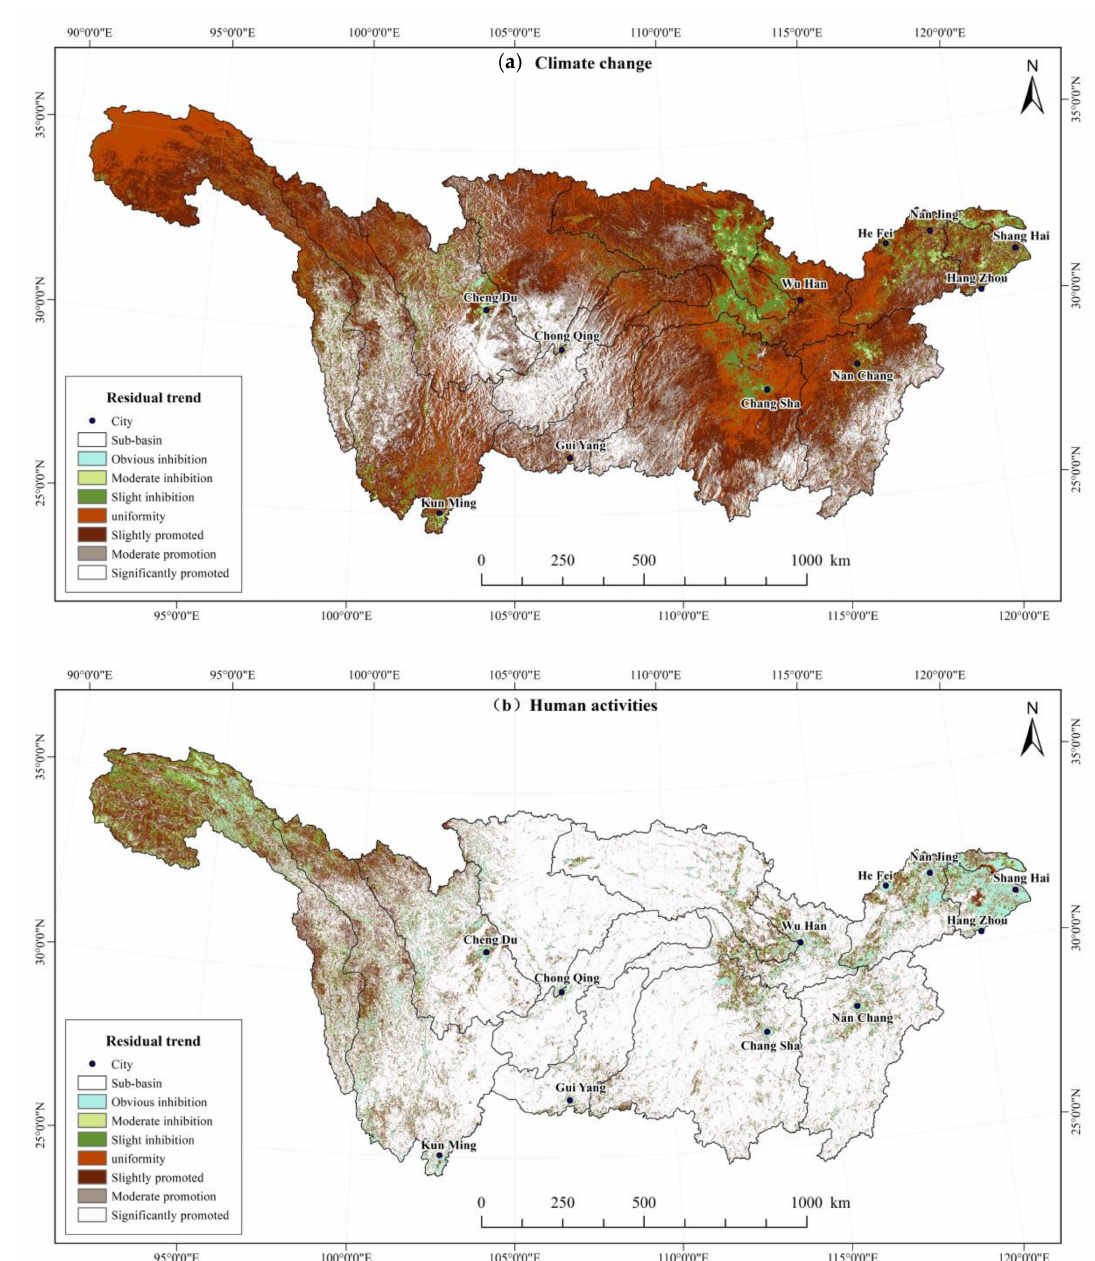
Figure 8. Spatial distribution of impacts of climate change and human activities on vegetation cover change in the Yangtze River Basin from 2000 to